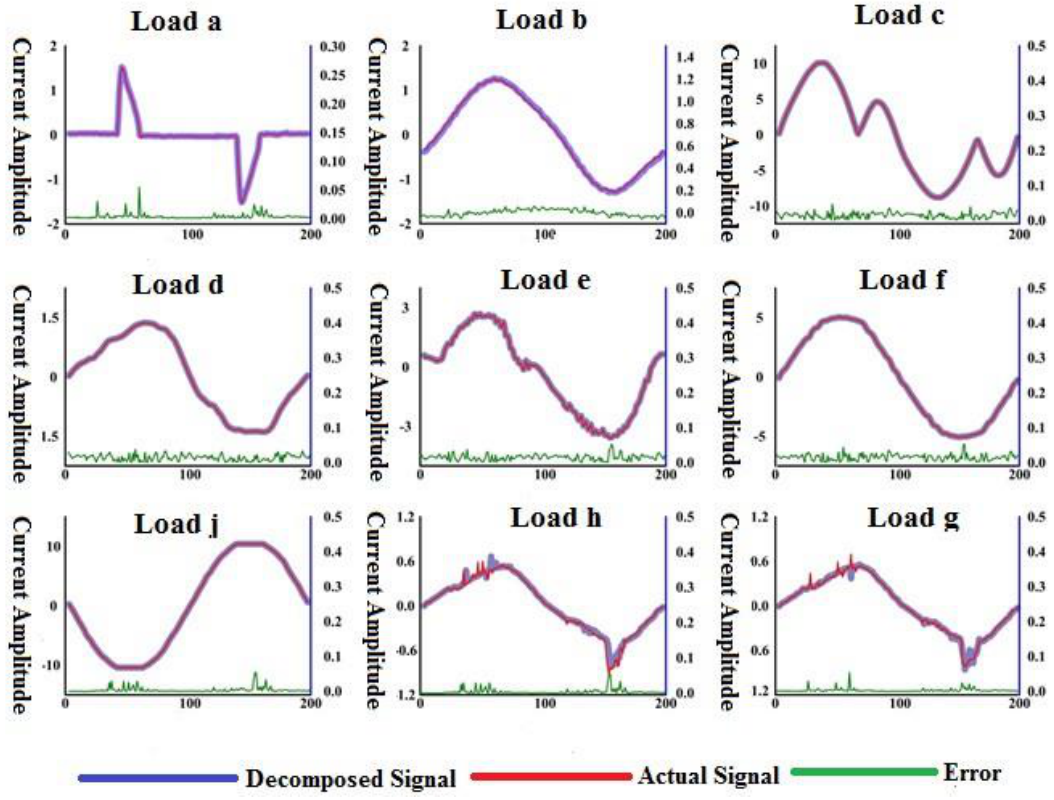
Figure 5 Comparison between decomposed signal and the actual signal in first home. Figure 5. Comparison between decomposed signal and the actual signal in first